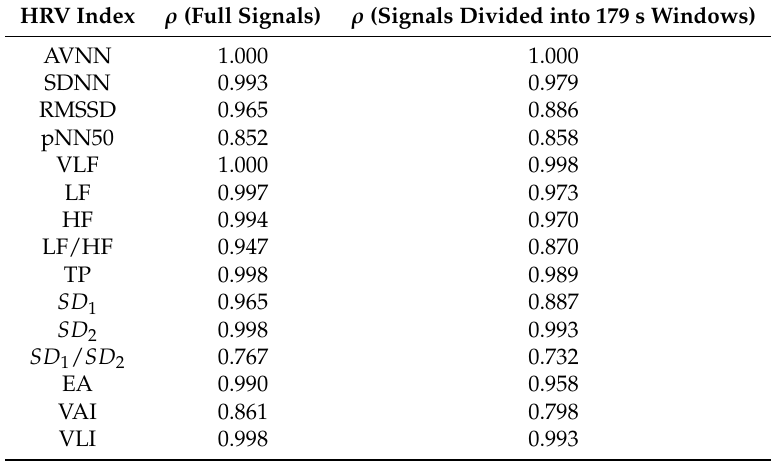
Table 6. Pearson’s linear correlation coefficient of HRV indices obtained on ECG and SCG signals. HRV Index ρ (Full Signals) ρ (Signals Divided into 179 s Windows)